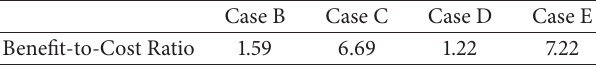
Table 2: Benefit-to-Cost Ratio for four different cases.